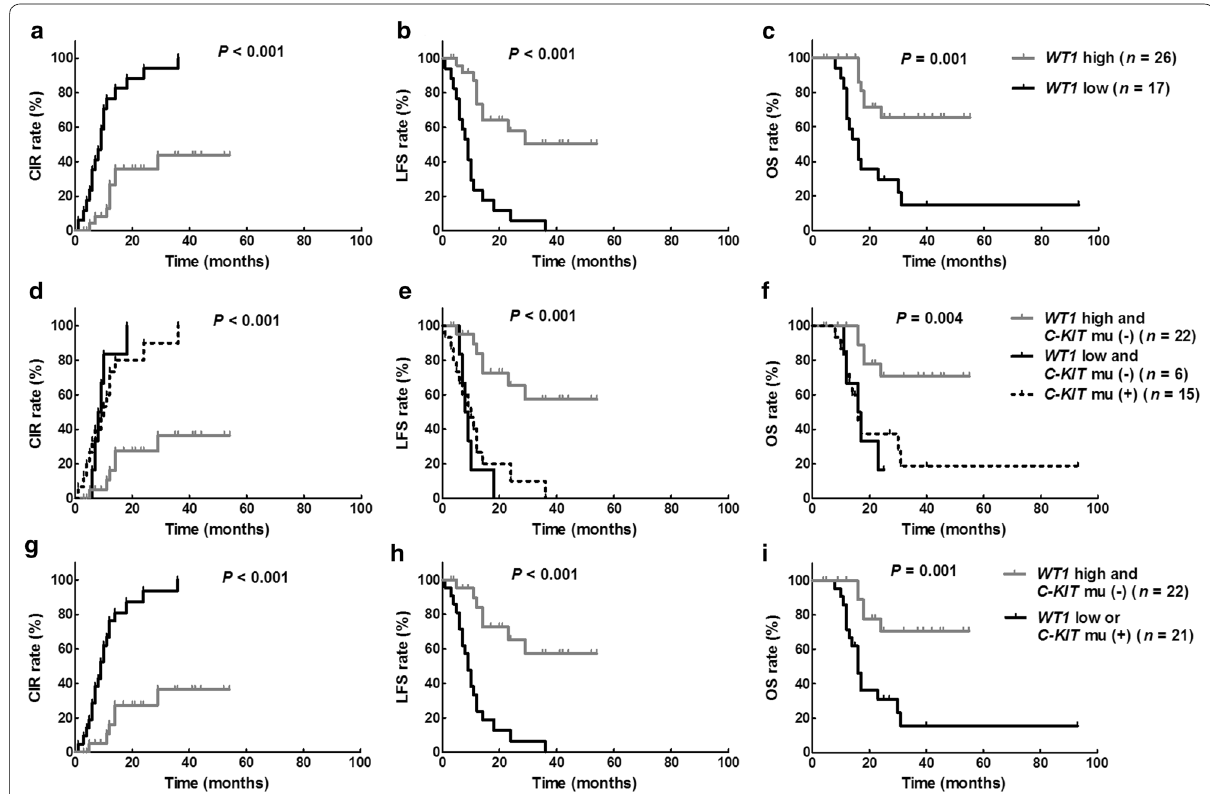
Fig. 2 Both WT1 transcript level and C ‑ KIT mutation at diagnosis were associated with outcomes in patients who received chemotherapy only. Patients were grouped by WT1 transcript level and/or C ‑ KIT mutation at diagnosis. a , d , g cumulative incidence of relapse (CIR) rate (%); b , e , h leukemia‑free survival (LFS) rate (%); c , f , i overall survival (OS) rate (%). Each row has the same labels that are shown on the right of the